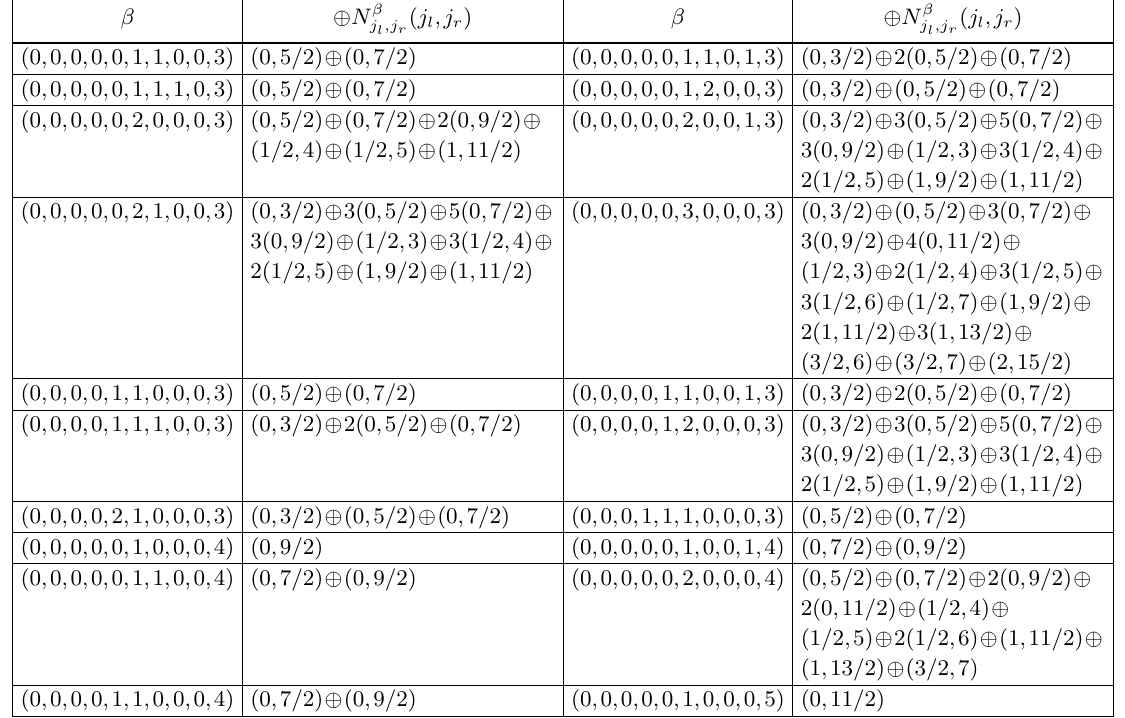
Table 27 . Re(cid:12)ned BPS invariants of 6d E 8 minimal